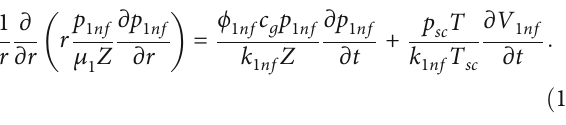
Figure 3: The fl ow rate distribution in the fi nite-conductivity